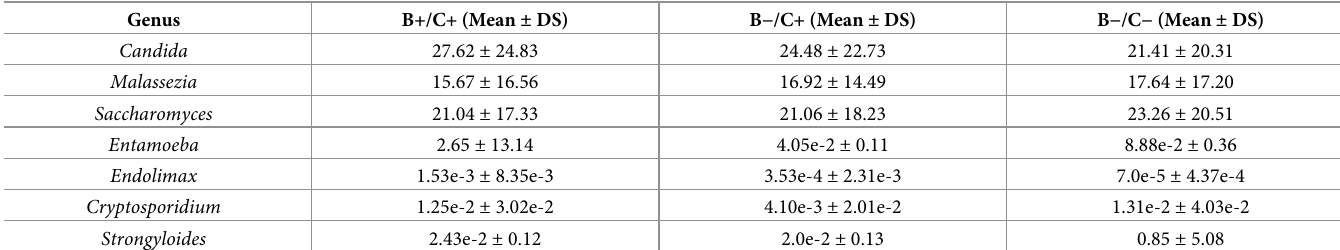
Table 2. Mean relative abundance of the seven genera of eukaryotes (CLIPPs, nematodes and fungi) selected for the three study groups. Genus